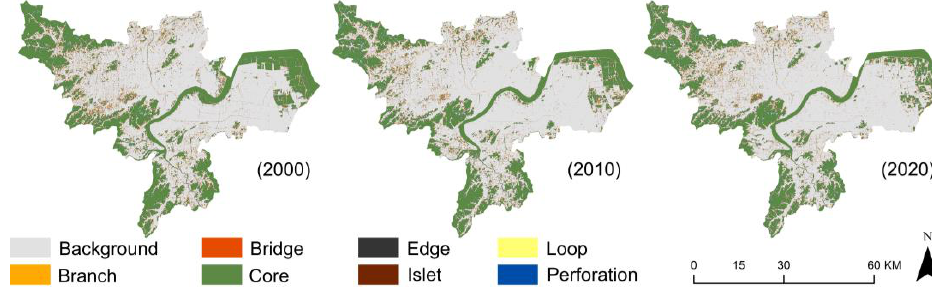
Figure 4. MSPA landscape types of the study area in 2000, 2010, and 2020.